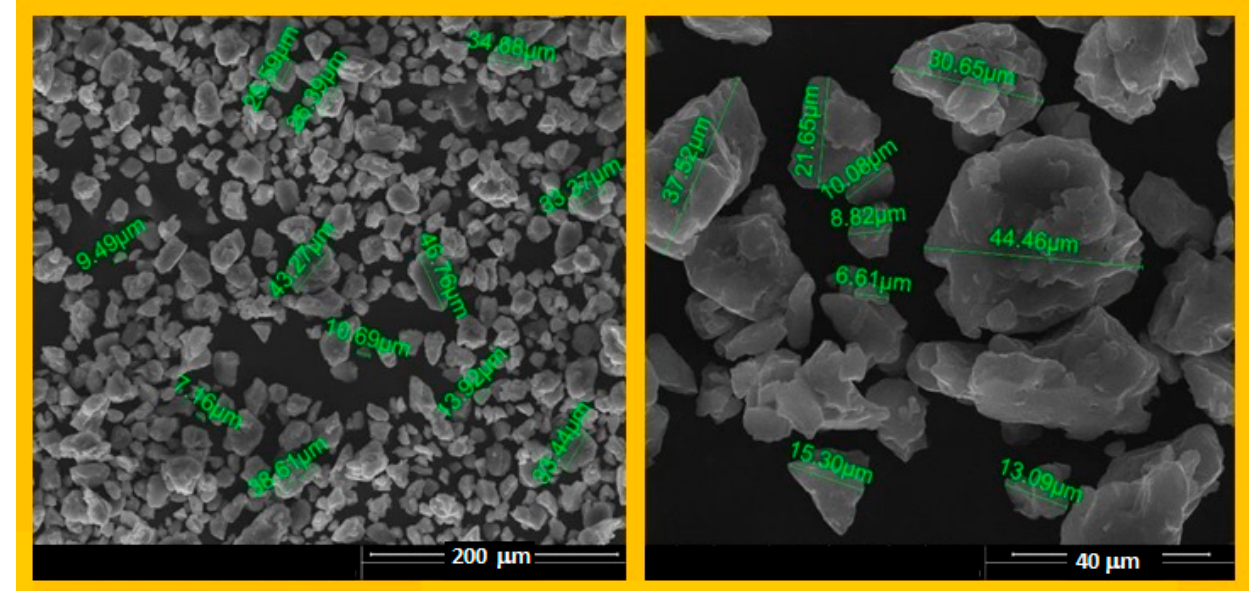
Figure 12. The SEM ‐ SE images for the Mg ‐ 4Zn ‐ 0.8Ca ‐ 0.5Zr alloy after MA with 300 rpm/28 h/10:1 Figure 12. The SEM-SE images for the Mg-4Zn-0.8Ca-0.5Zr alloy after MA with 300 rpm/28 h/10:1 applied parameters and final sieving < 30 μ m. applied parameters and final sieving < 30 µ m.